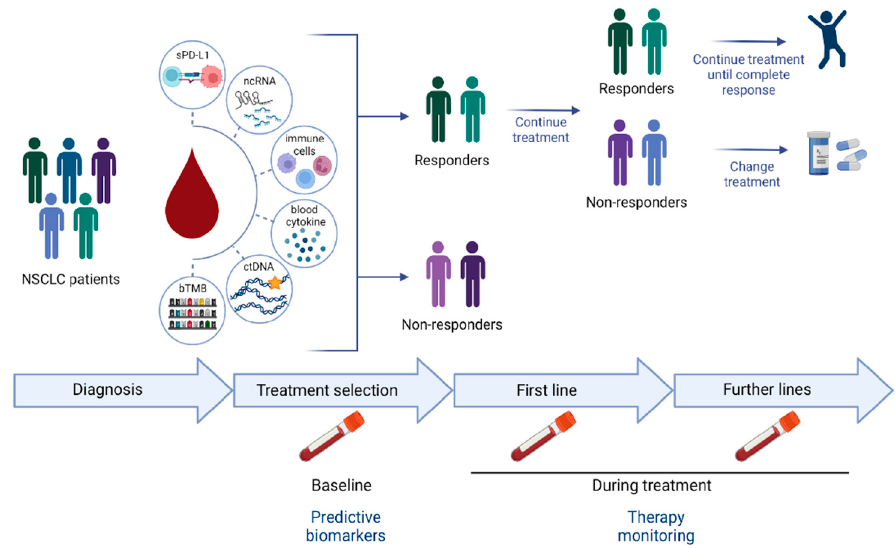
Figure 1. Potential clinical applications of liquid biopsy: soluble biomarkers can be used for ICI response prediction at baseline prior to treatment selection, enabling tracking of tumor evolution during the treatment.